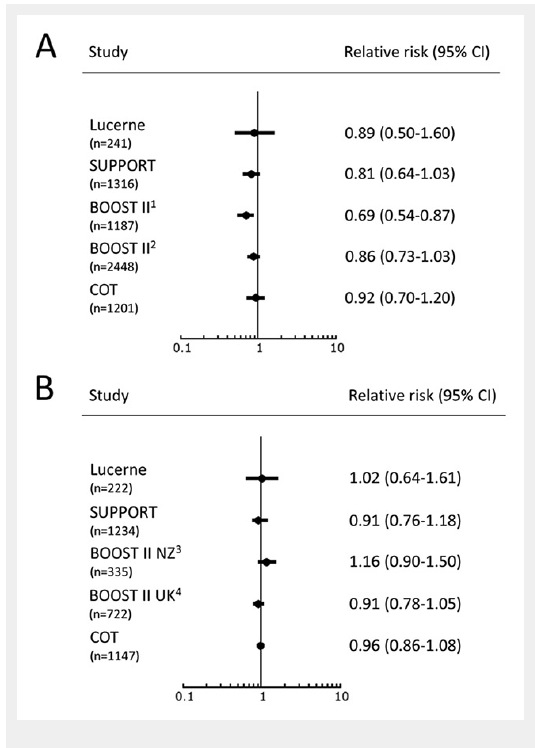
Forest plots of mortality (A) and death or disability (B) in ELGANs in high vs low SpO 2 target cohorts. (RR below 1 favours high SpO 2 target) 1 revised oximeter-calibration algorithm cohort